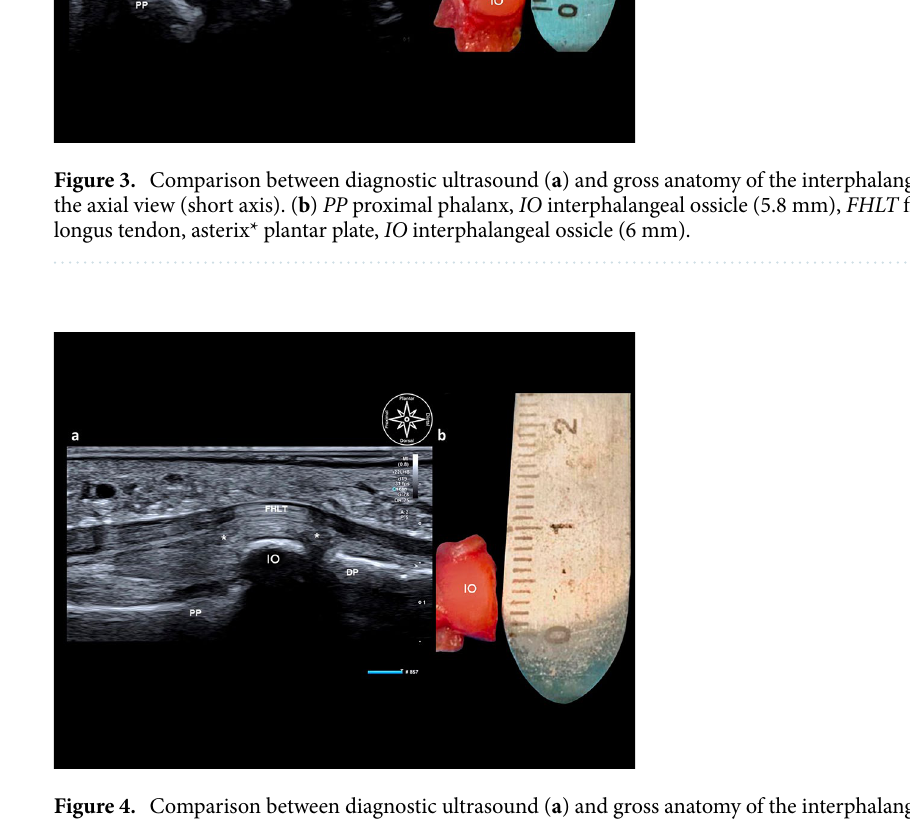
Figure 4. Comparison between diagnostic ultrasound ( a ) and gross anatomy of the interphalangeal ossicle in the sagittal view (long axis). ( b ): PP proximal phalanx, DP distal phalanx, IO interphalangeal ossicle (3.7 mm), FHLT flexor hallucis longus tendon, asterix* plantar plate, IO interphalangeal ossicle (6